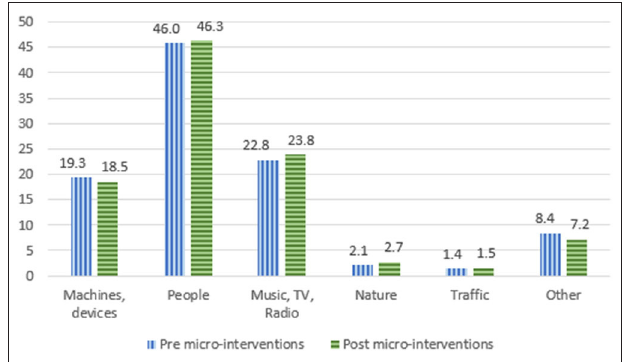
FIGURE 4 | Sources of sounds pre- and post-implementation of micro-intervenntions (%).